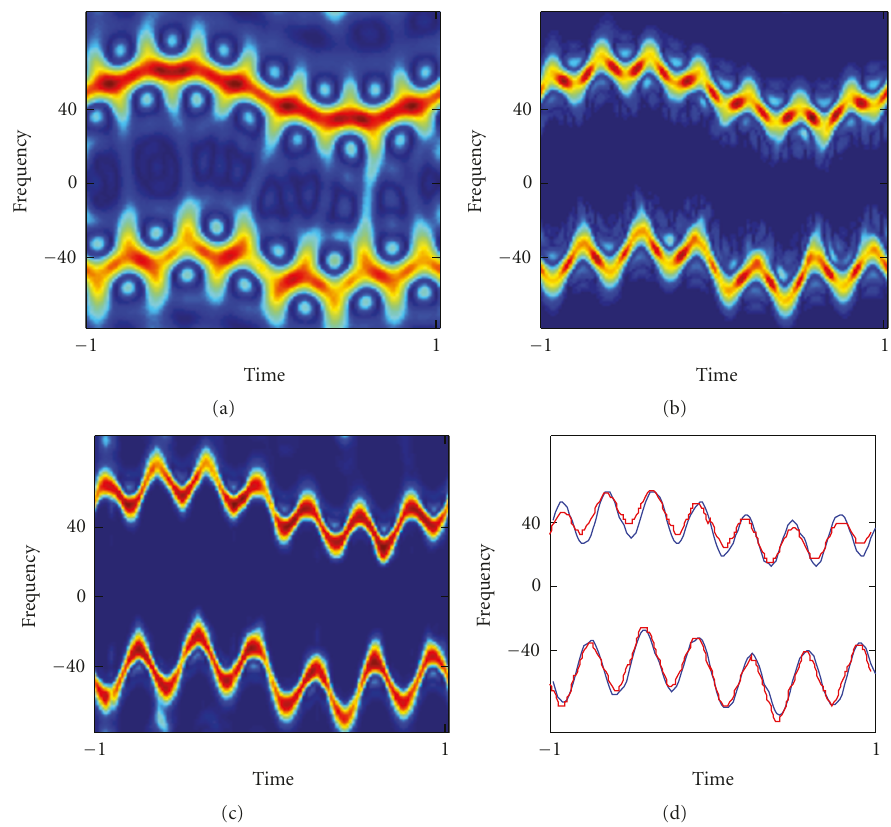
Figure 2: The complex time-frequency distributions from the proposed class for: (a) N = 2; (b) N = 4; (c) N = 6; (d) the exact instantaneous frequency (blue line) and estimated instantaneous frequency from GCD AF , N =